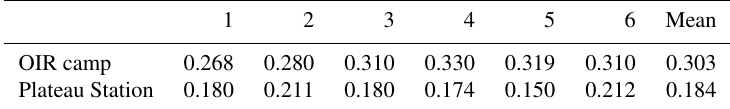
Table 5. Maximum height differences (m) along transects one to six at Plateau Station and B56.